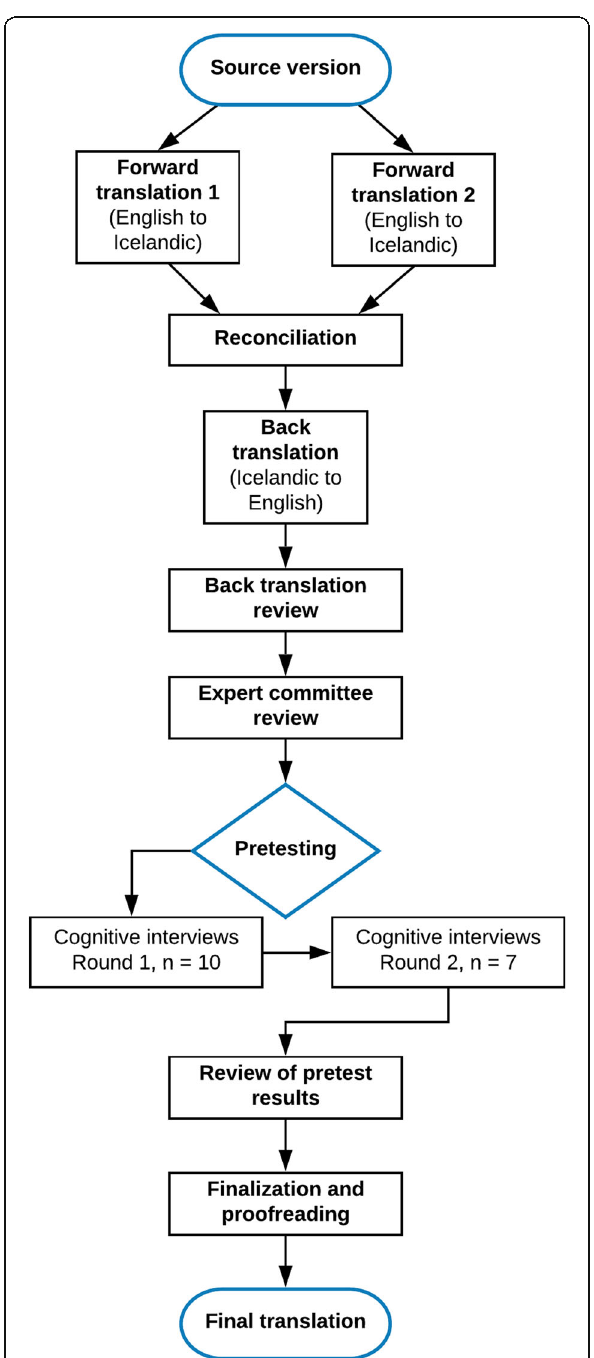
Fig. 1 A flowchart of the cross-cultural adaptation